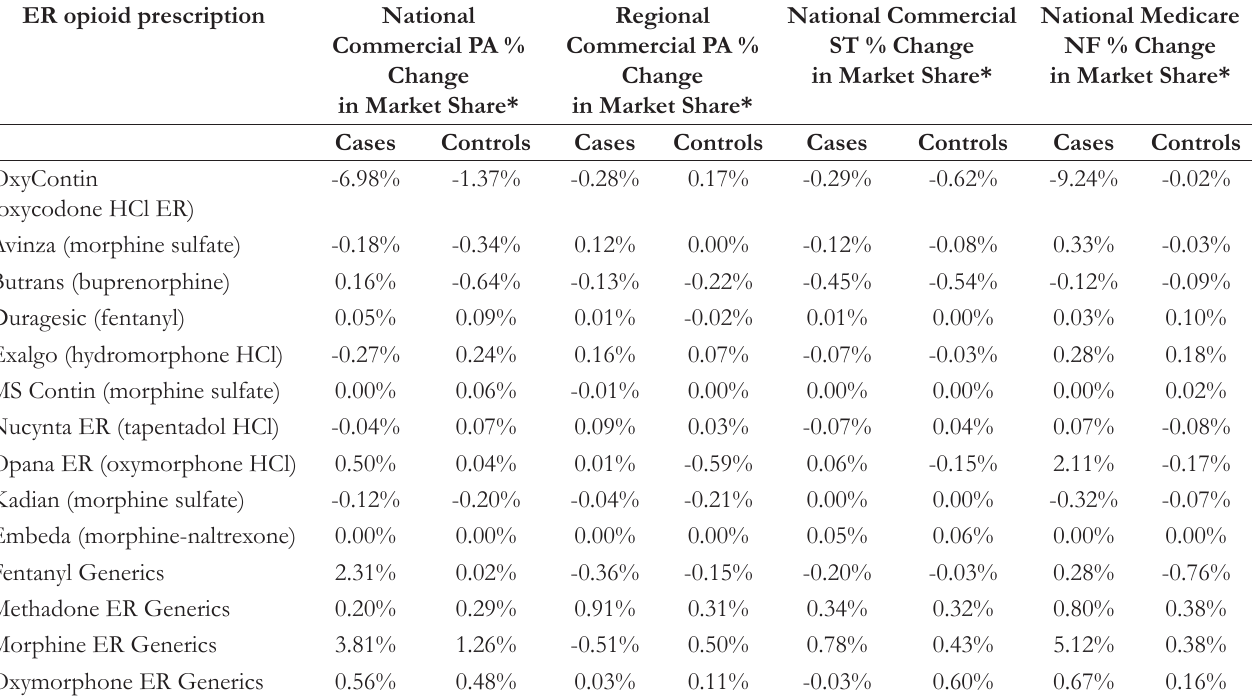
Table 3. Change In Extended-release Opioid Market Share Across Health Plans Post OER